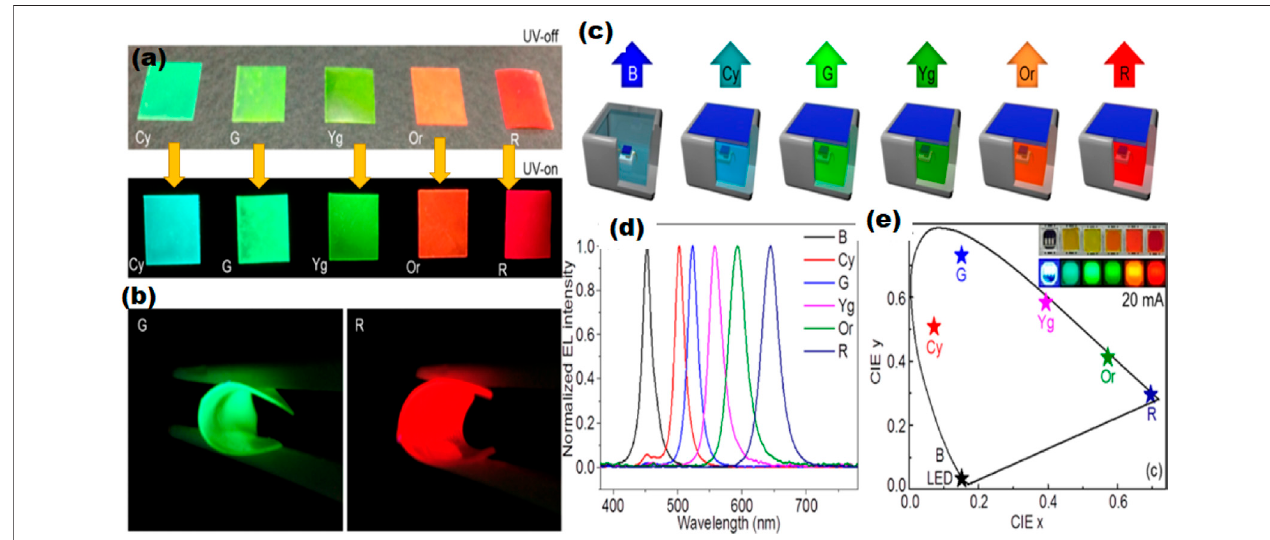
FIGURE 14 | (A) CsPbX 3 PQD polymer fi lms with various halide under ambient light and under UV light. (B) CsPbBr 3 and CsPb(Br 0.35 I 0.65 ) 3 PQD fl exible sheet under UV light irradiation, (C,D) different light emission of blue-chip, PL spectra, and (E) CIE spectra of CsPbX 3 PQD.